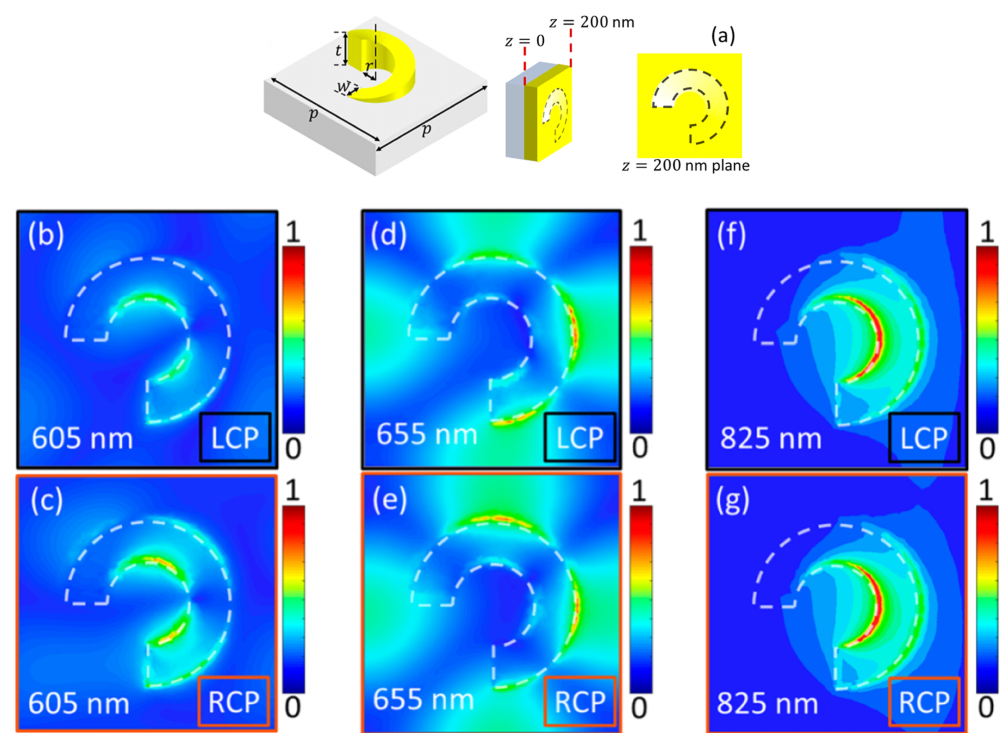
Figure 2. ( a ) Illustration of a single ramp-shaped chiral plasmonic nanostructure and its geometrical parameters. ( b )–( g ) The near-field maps at the three major resonances of the structure: 605 nm; 655 nm; and 825 nm for LCP and RCP incident light. Calculations were performed for a 2D periodic array of ramp-shaped structures, with r = w = 100 nm, t = 200 nm and a period length of p = 600 nm. Results for the electric field amplitude are normalized to E 0 = 1.76 × 10 9 . Reproduced with permission from ref. [49]. Copyright 2019 American Chemical Society.